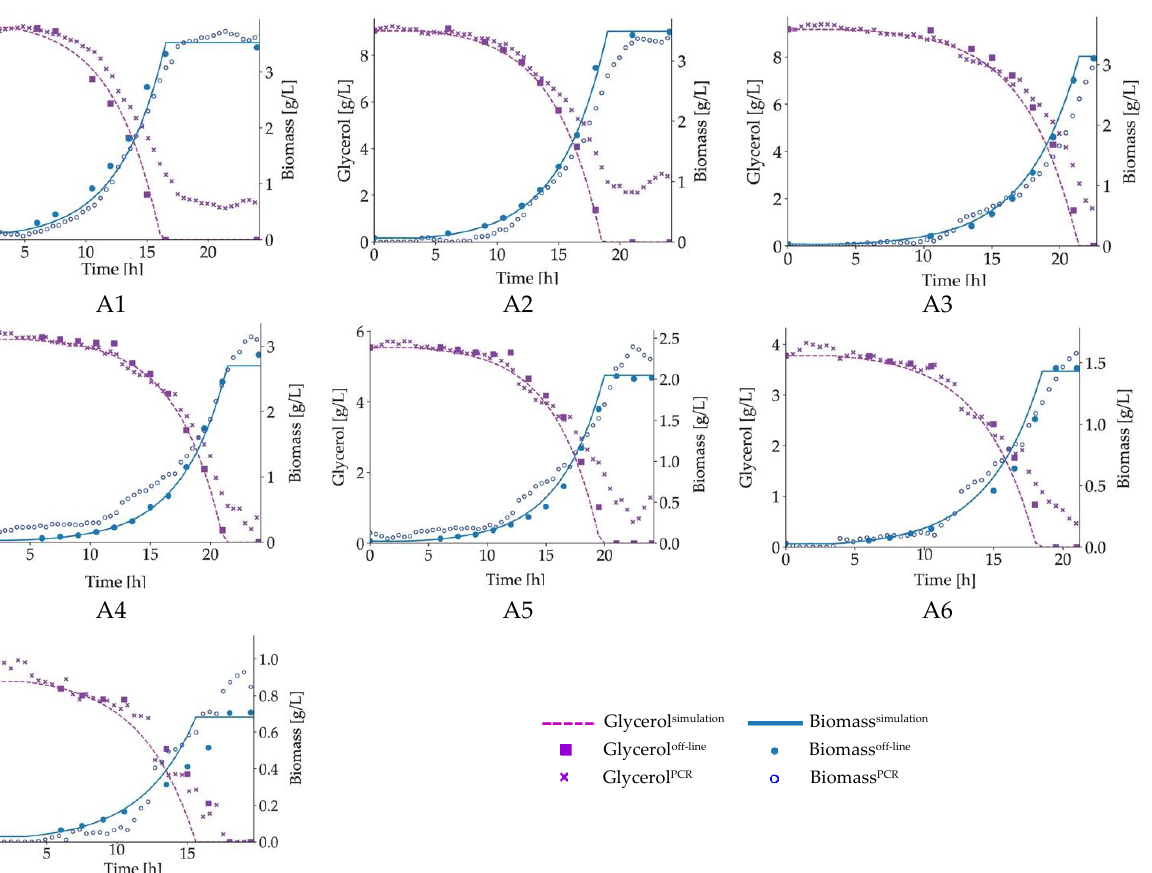
Figure 4. Validation of chemometric model (PCR) from 2D fluorescence spectra calibrated by the MBC approach to predict biomass (Biomass PCR ) and glycerol (Glycerol PCR ) aligned with offline measurements from seven cultivations ( A1 – A7 ) and with the different initial conditions presented in Table 1.